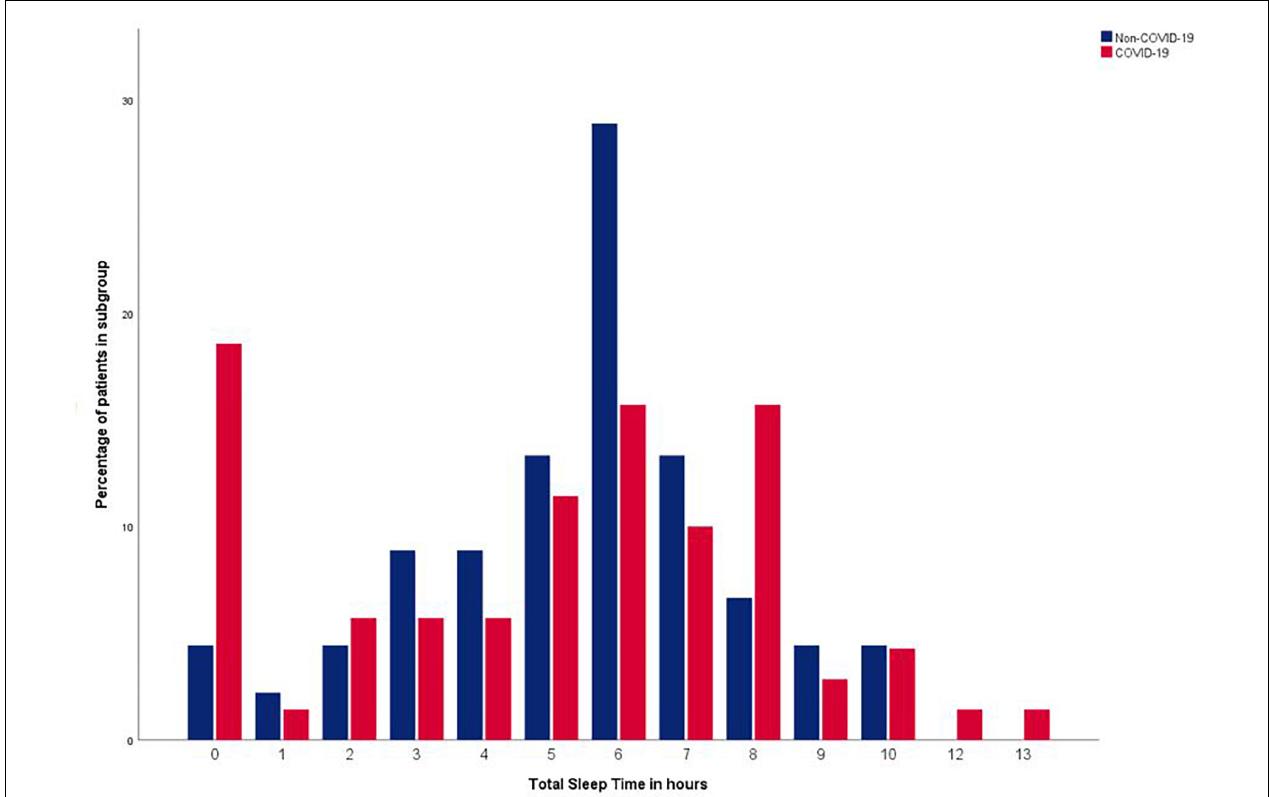
FIGURE 2 | Distribution of Total Sleep Time within COVID-19 and non-COVID-19